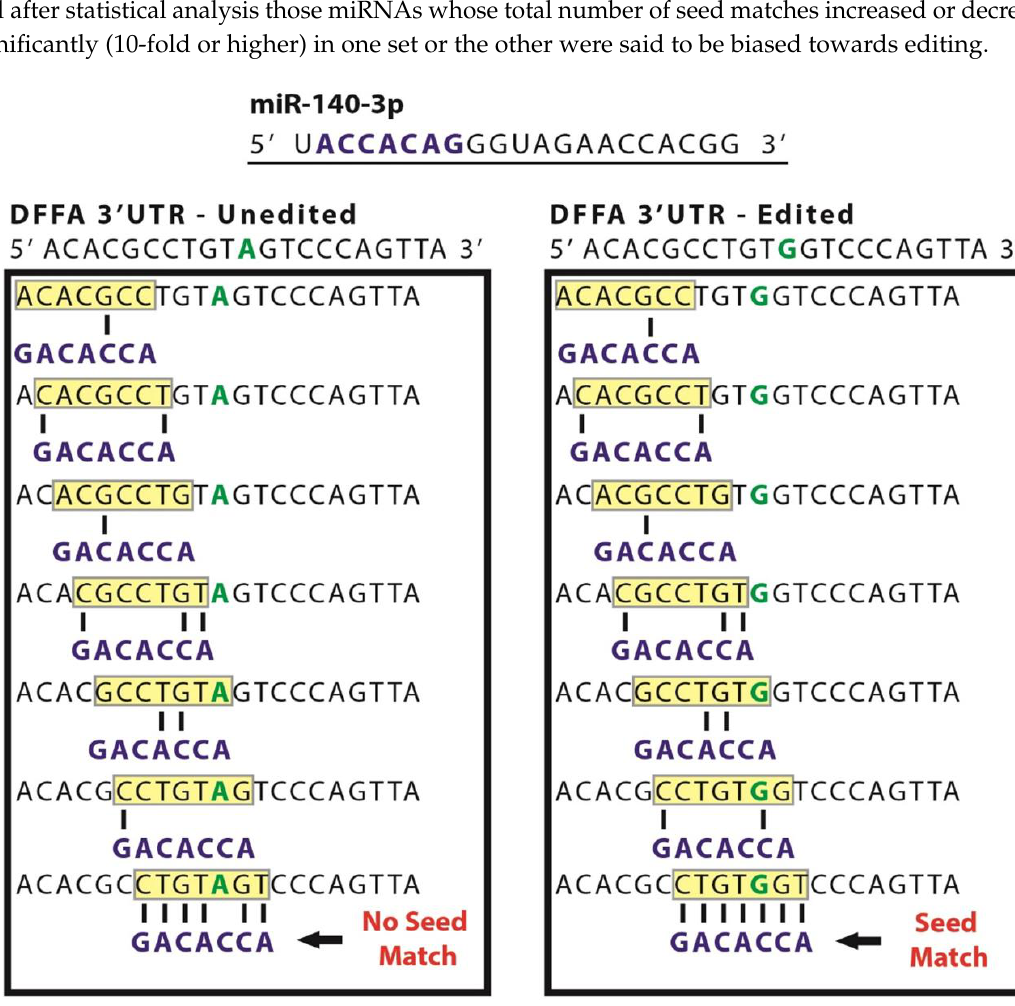
Figure 2. Effect of RNA editing on DFFA. A representative deamination site (green) occurring in the 3′ UTR of DNA fragmentation factor α (DFFA) is shown in both the unedited ( left ) and edited ( right ) state. The seed of miR-140-3p (blue) was screened using a sliding windows approach (depicted with a yellow box) against all possible seed matches within the DFFA sequence. Complimentary base pairing is indicated by the black lines.